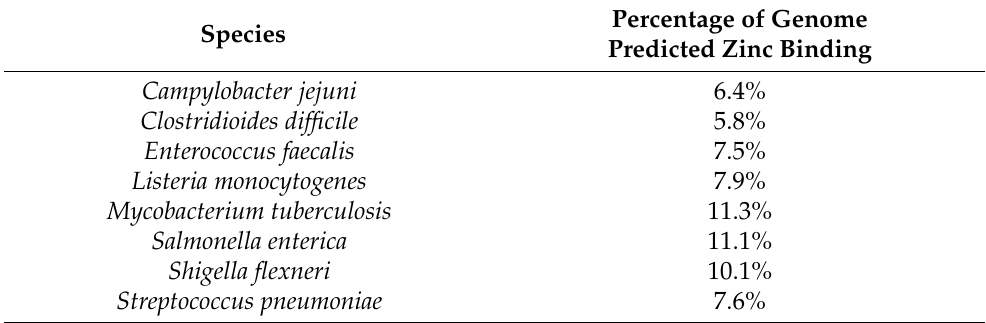
Table 4. Percentage of protein sequences encoded in the genome predicted to be zinc binding by ZincBindPredict for an assortment of bacterial genomes. Genomes were acquired from ensembl [25] in the form of translated polypeptide sequences, with a sequence labelled as zinc binding if any of the ten models finds at least one zinc binding site for that sequence/family combination. See Supplementary File genomes.zip for the full